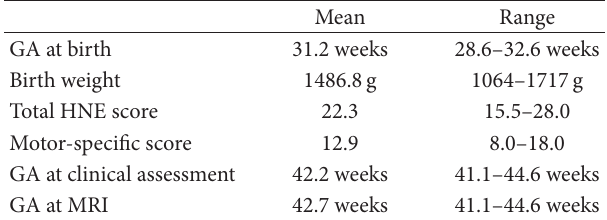
T 1: Descriptive data pertaining to infant characteristics, clinical assessment scores, and GA at assessments.